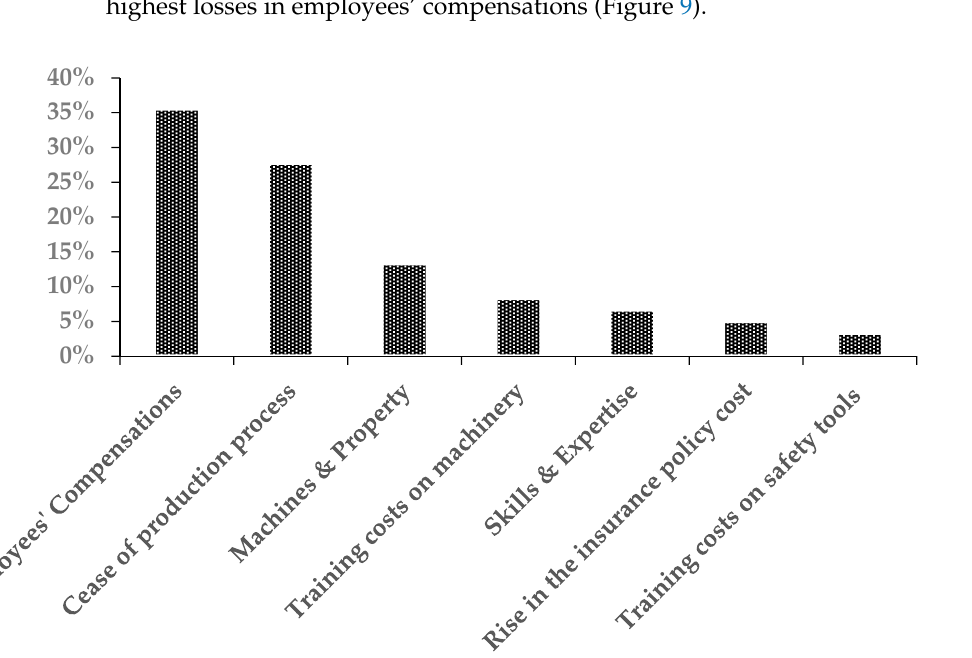
Figure 9. The percentages of the industrial establishments’ losses due to occupational